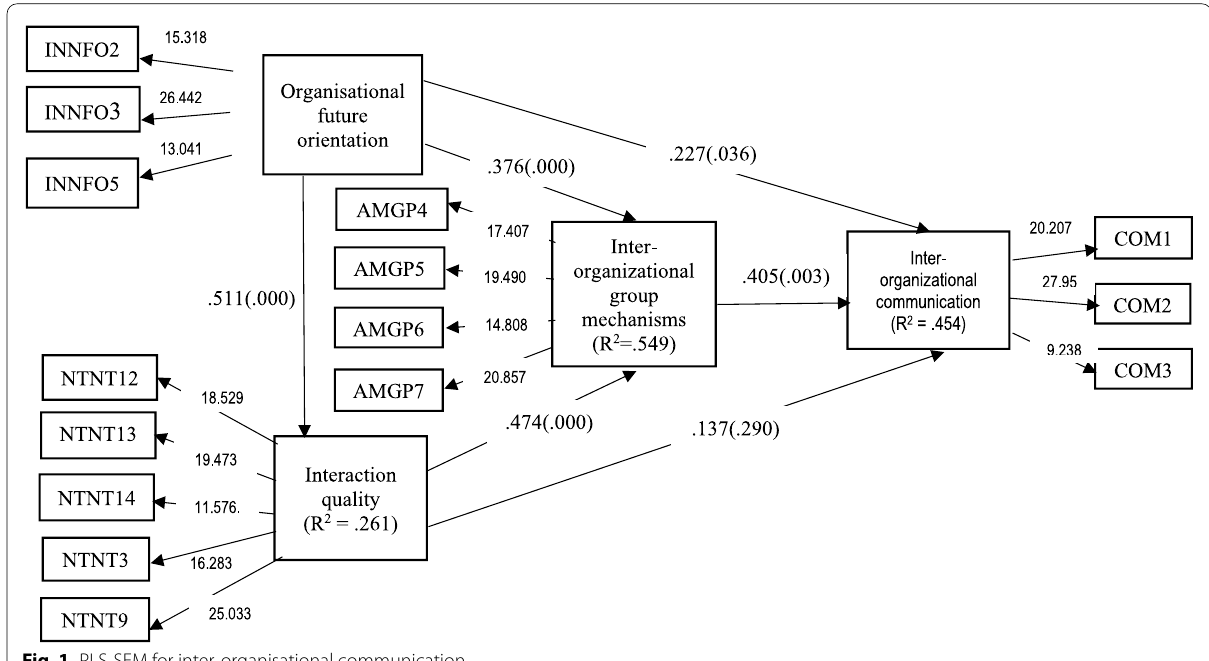
Fig. 1 PLS-SEM for inter-organisational